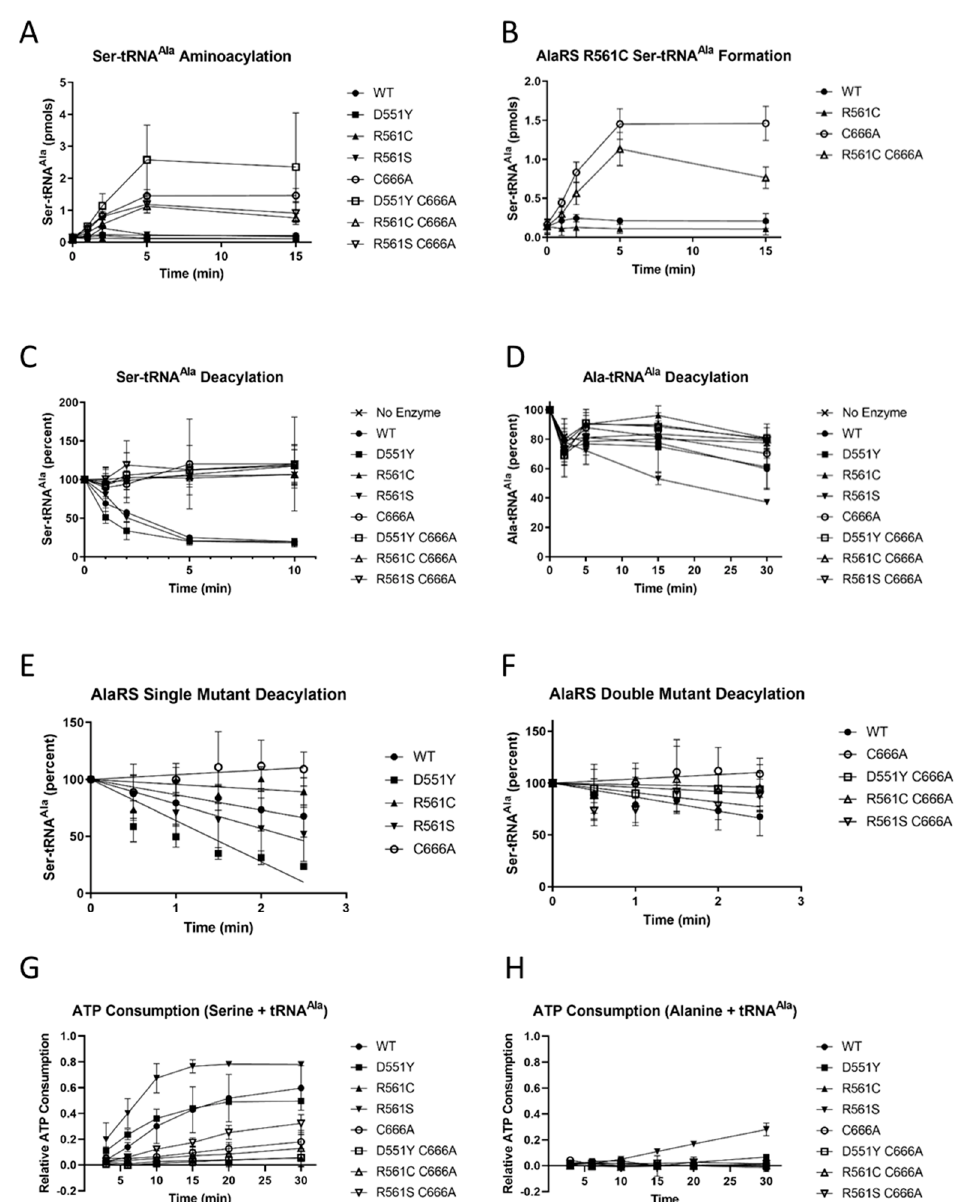
Figure 5. In vitro characterization of AlaRS C666A suppressors. The three identified AlaRS C666A suppressors were assayed for ( A ) mis-serylation activity and results from the ( B ) AlaRS R561C mutants were further analyzed. The proofreading activity of the enzymes were examined over a time course for ( C ) Ser-tRNA Ala and ( D ) Ala-tRNA Ala substrates. Furthermore the initial rates of Ser-tRNA Ala deacylation were monitored for the ( E ) single mutants and ( F ) double mutants. Finally, ATP consumption was observed for reactions including tRNA Ala and ( G ) serine or ( H )